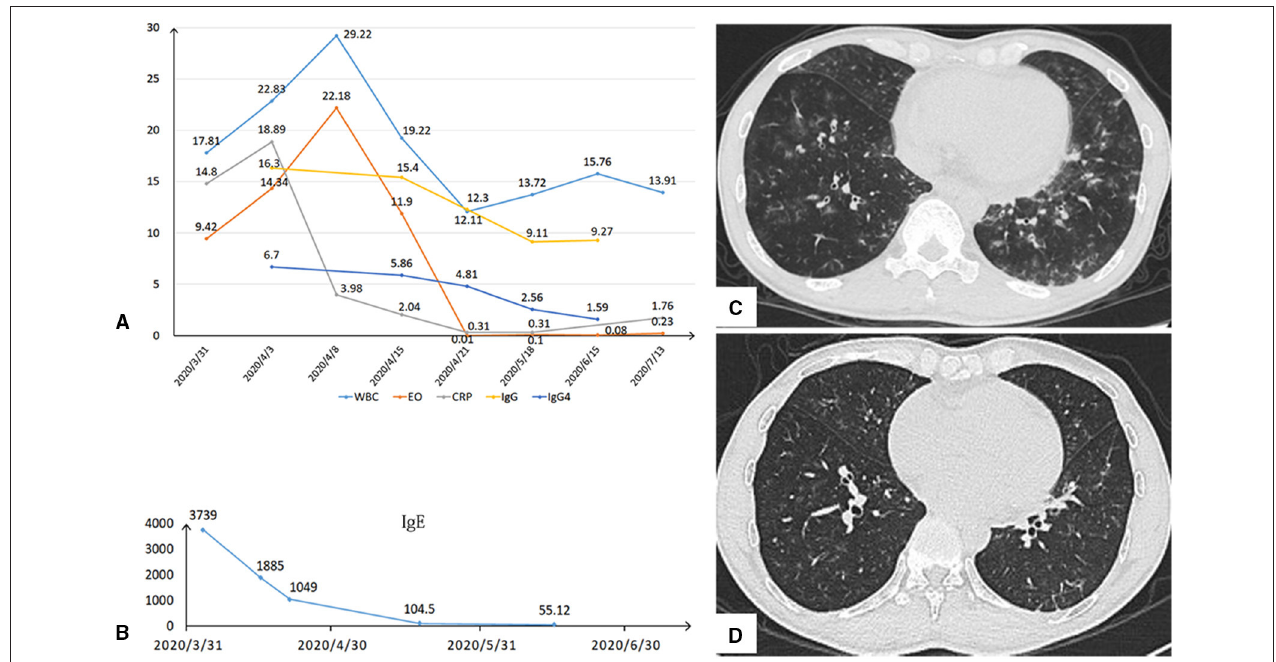
FIGURE 2 | (A,B) After comprehensive treatment, the white blood cells (WBC), eosinophilia (EO), CRP, IgG, IgG4, and IgE responded rapidly and kept dropping down. (C) Chest CT indicated multiple lung infiltrates and small patches of ground-glass appearance in both lungs initially. (D) After half-a-month antibiotic therapy, the lung infiltration infiltrates obviously disappeared.